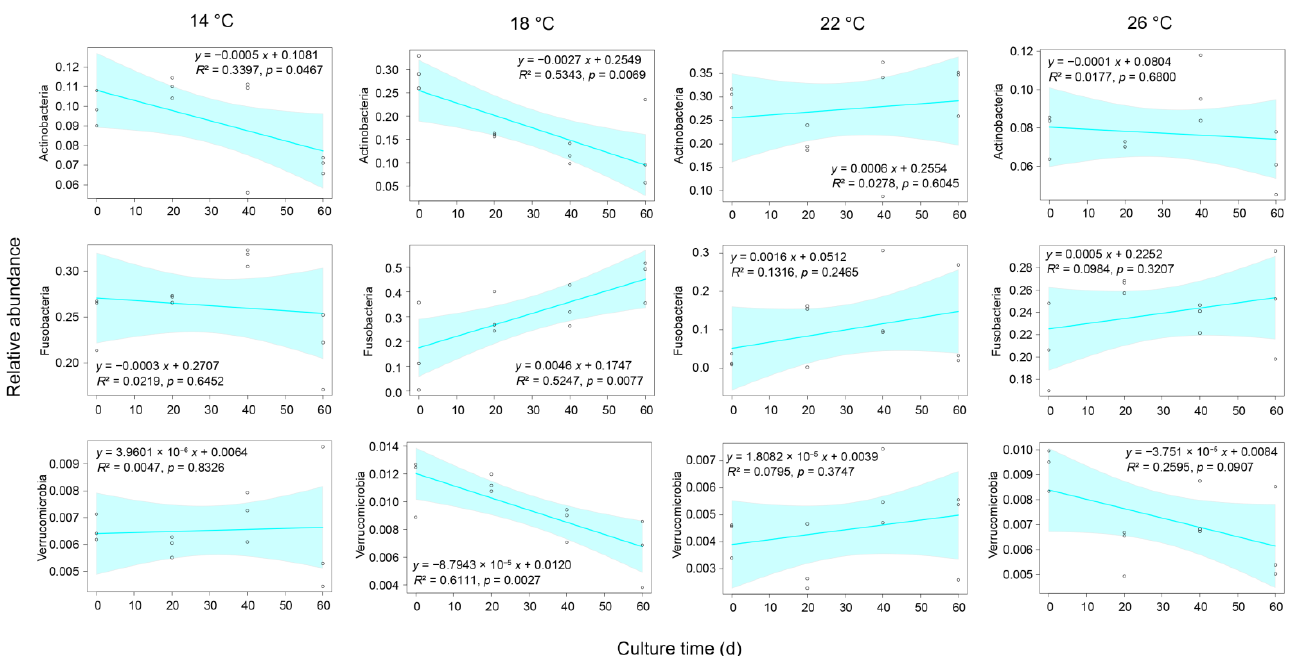
Figure 4. Correlation between the culture time and the relative abundances of Actinobacteria , Fusobacteria , and Verrucomicrobia in Percocypris pingi gut microbiota. Dots in the boxplots indicate values measured in samples.